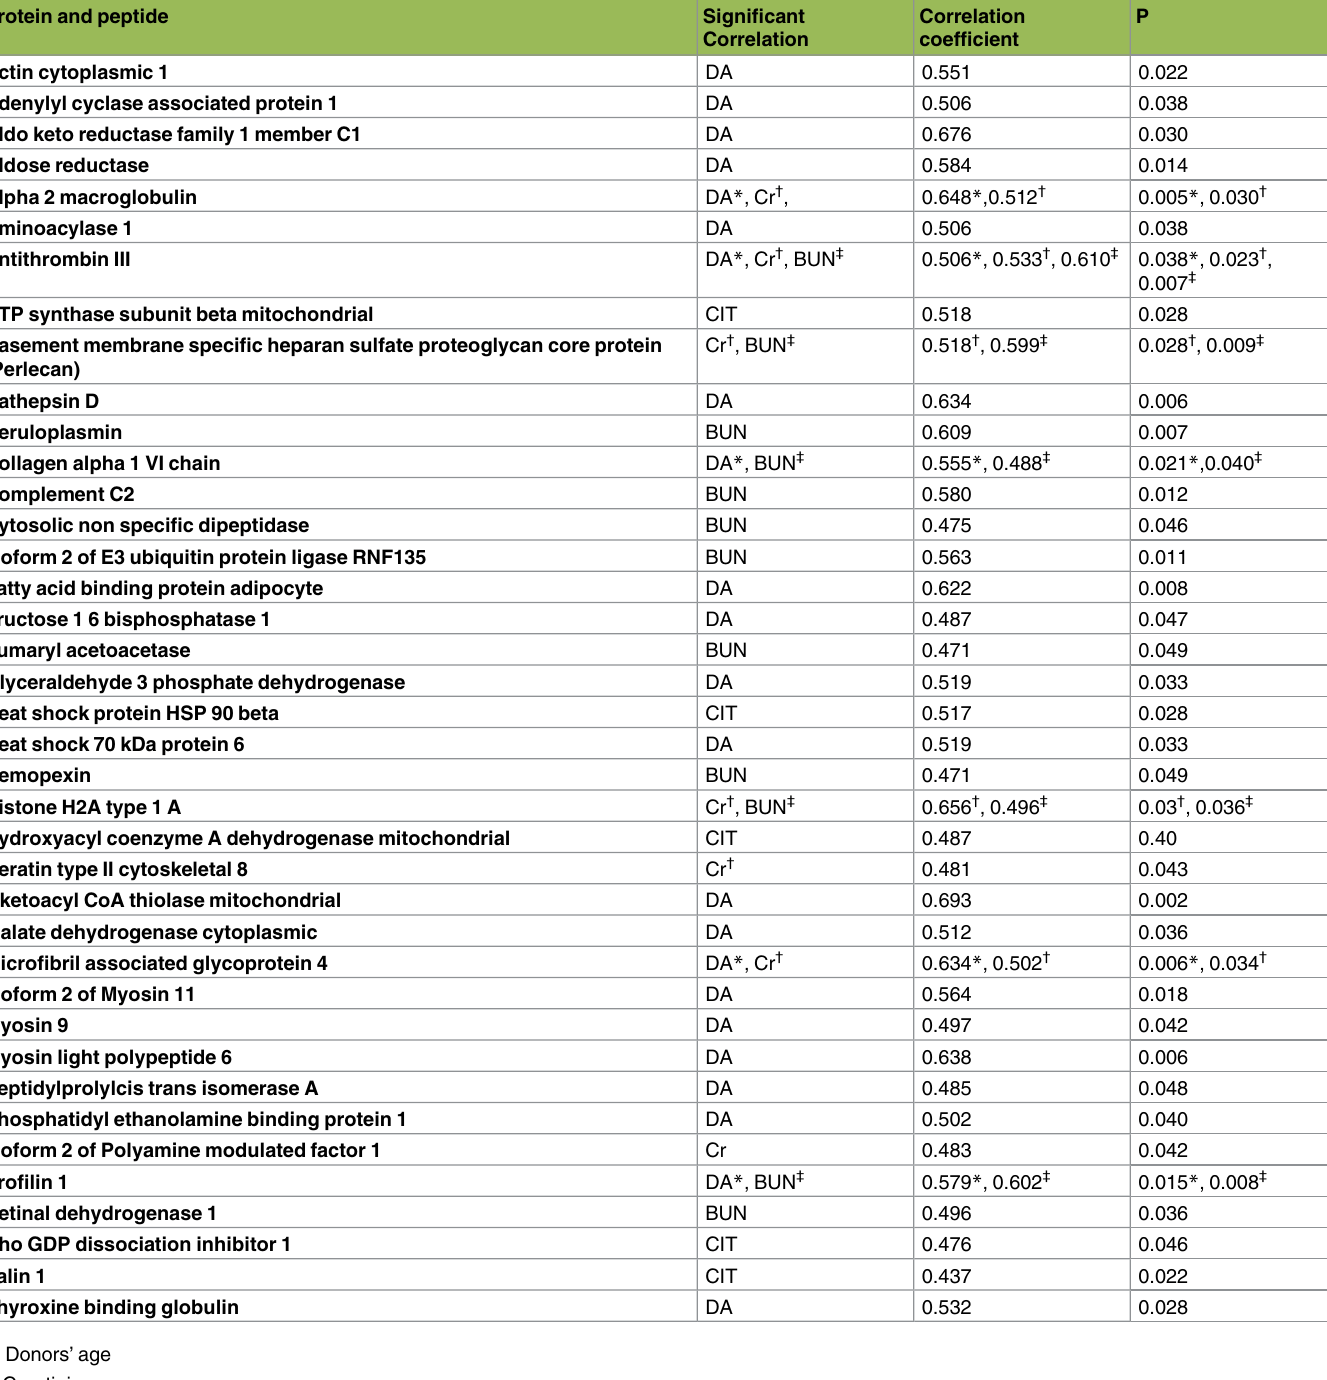
Table 2. List of proteins and peptides that were isolated from kidney preservation solution which showed a statistically significant correlation with donors’ age (DA), cold ischemia time (CIT), creatinine (Cr) and blood urea nitrogen (BUN). Protein and